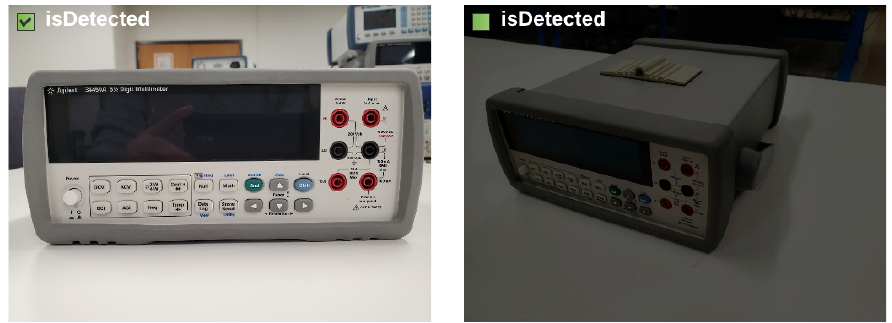
Figure 11. Image reference of Samsung s21 camera with a light intensity of 350 lux ( Left ) and 25 lux ( Right